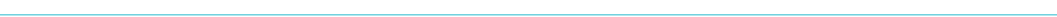
Figure 2: Cost-effectiveness diagram of bronchoscopic lung volume reduction (BLVR) using endobronchial valves (EBVs) compared with lung volume reduction surgery (LVRS).The 0-point of the diagram corresponds to the LVRS. The coloured points correspond to the different effec- tiveness qualities of BLVR (FEV1, RV and 6MWD).In general, interventions located in quadrant IV are medically superior and more cost-effec- tive. In this case, BLVR would be superior to LVRS. In terms of FEV1, however, BLVR is in quadrant II, so that the zero-alternative, i.e. LVRS, dominates. If FEV1 were the only measure of effectiveness, BLVR would have to be rejected. In terms of RV and 6MWD, BLVR is in quadrant I, where the better result is offset by higher costs. For interventions located in quadrant I, it is completely unclear whether they should be